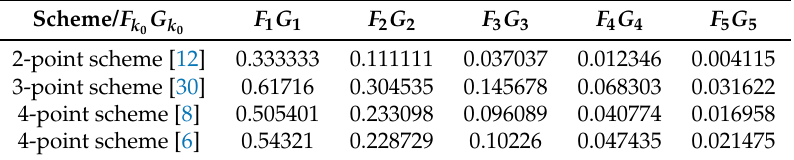
Table 6. Associated constants of ternary subdivision surfaces.